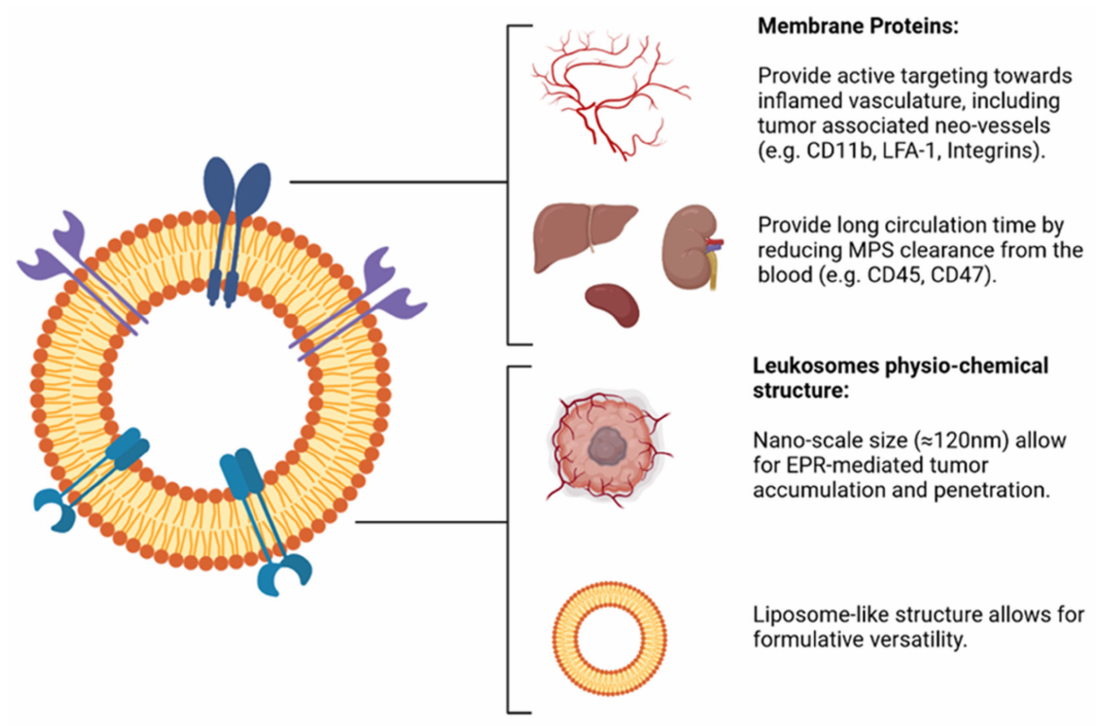
Figure 8. Schematic representation of the structure and functions of leukosomes. EPR: enhanced permeability and retention effect. Image adapted from [77] under creative commons